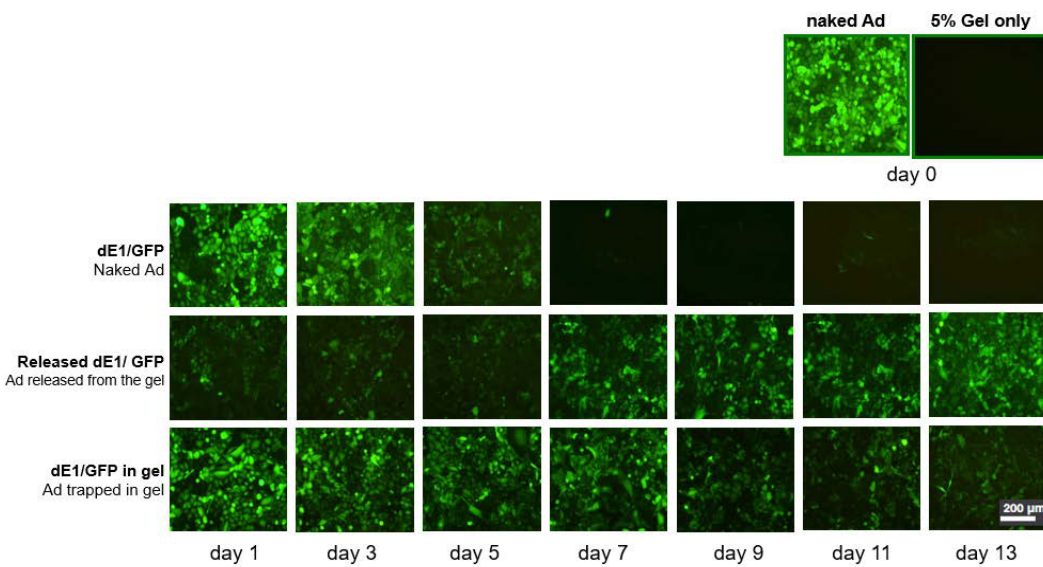
Figure 1. Comparisons of GFP (Green Fluorescent Protein) expression level by fluorescent microscopies showing SK-Hep1 cells incubated with adenoviral vector (Ad) in various forms. Ad (1 × 10 10 viral particle of dE1 / GFP) was encapsulated in 5% alginate gel and incubated with Dulbecco’s modified Eagle’s medium at 37 ◦ C for 1, 3, 5, 7, 9, 11, and 13 days. SK-Hep1 cells transduced with dE1 / GFP (naked Ad, top row), released Ad from 5% gel (middle row), and dissolved Ad-gel (lower row). GFP expression from naked Ad is strong at the beginning and dims after day 7, whereas from cells transduced with gel-release Ad accumulated amounts of released Ad gradually increased on day 13 versus day 1. Additionally, GFP expression of Ad in dissolved gel was prolonged until day 13. These results demonstrates that Ad in alginate gel is released over time in a sustained manner.